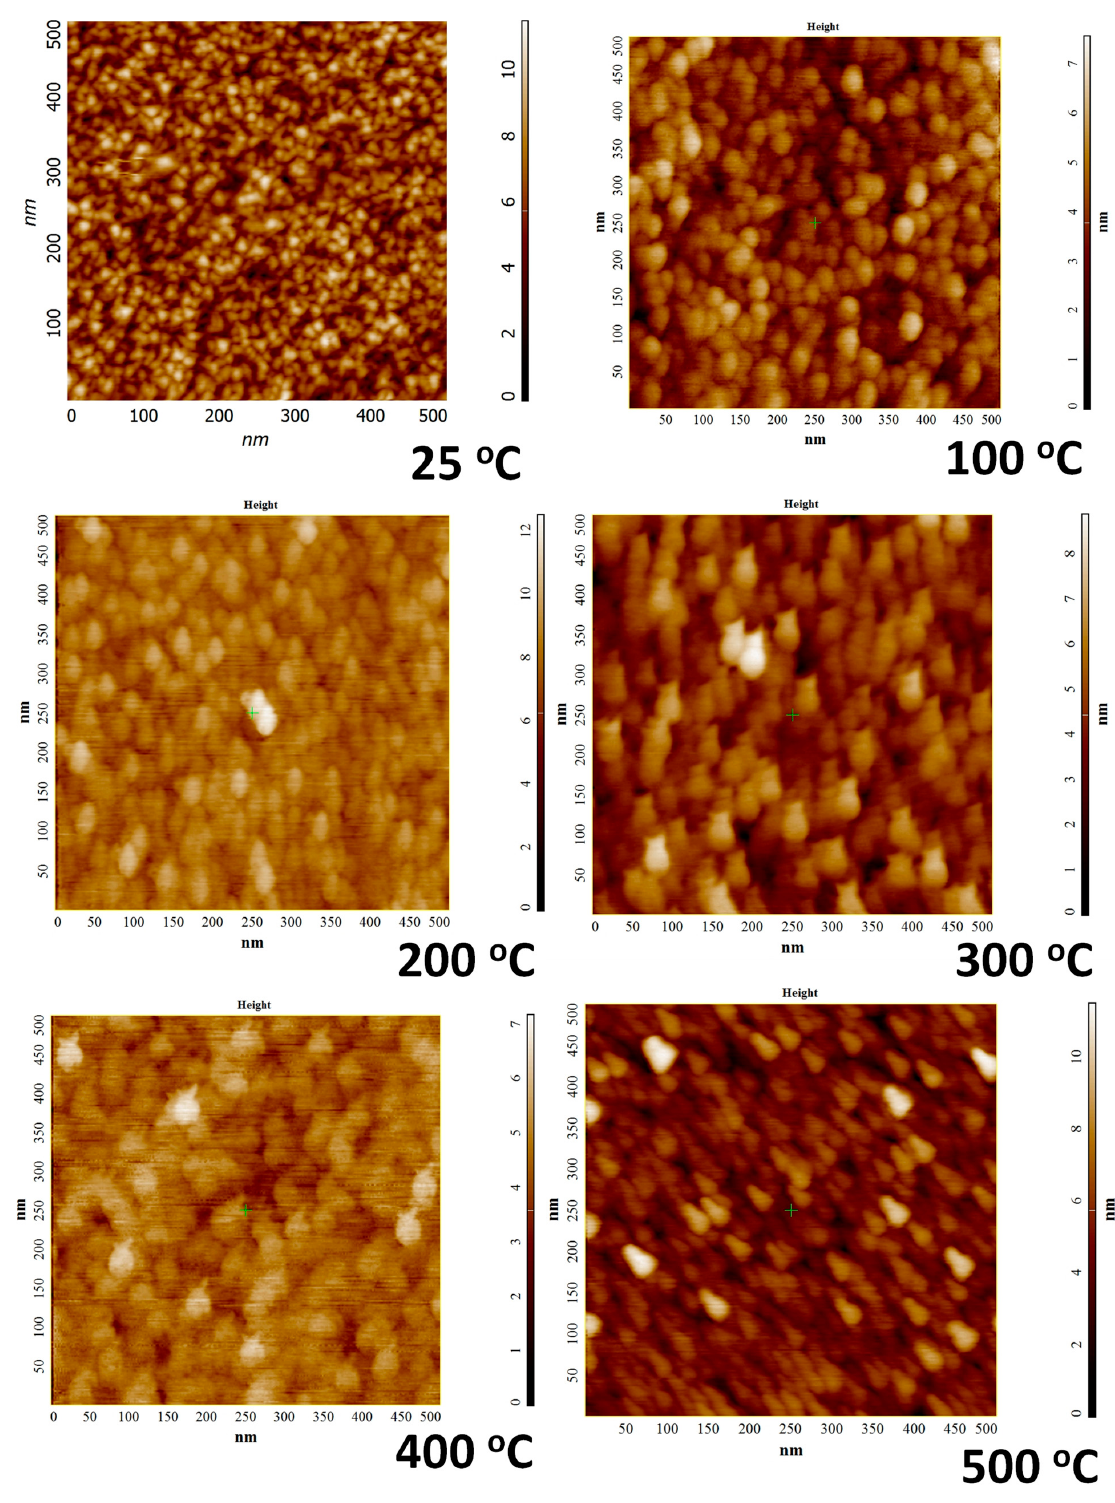
Figure 2. AFM topographic surface images of Mo films deposited under variable deposition tem- perature. The morphology evolution with increasing deposition temperature is evident. Also, the granular morphology with relatively smaller grain size formation at lower deposition temperatures can be seen in the AFM images.